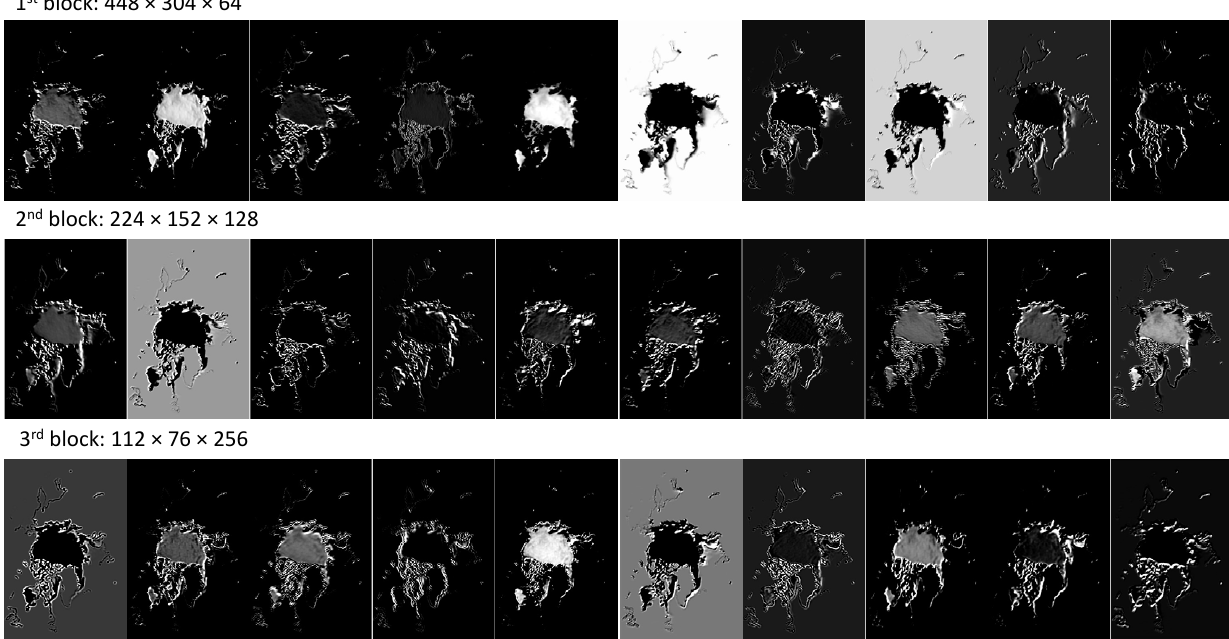
Figure 6. Examples of feature maps from the first three VGG blocks.